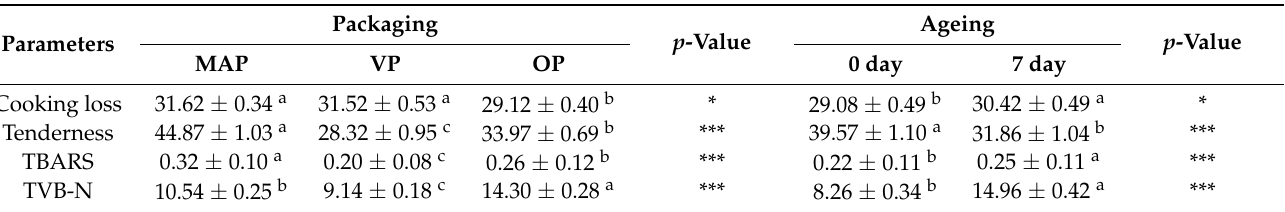
Table 3. Effect of packaging and ageing on cooking loss (%) and tenderness (N/cm 2 ) of buffalo bulls longissimus lumborum steaks after 7 days of retail